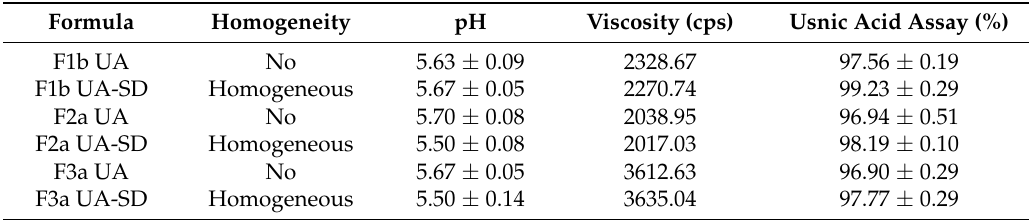
Figure 1. Hydrogels of usnic acid in different gelling agent ( a ) Aqupec, ( b ) sodium alginate, ( c ) HPMC. Table 3. Result of hydrogel test.